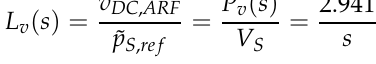
Figure 8. Bode plot of the frequency response of the current loop.